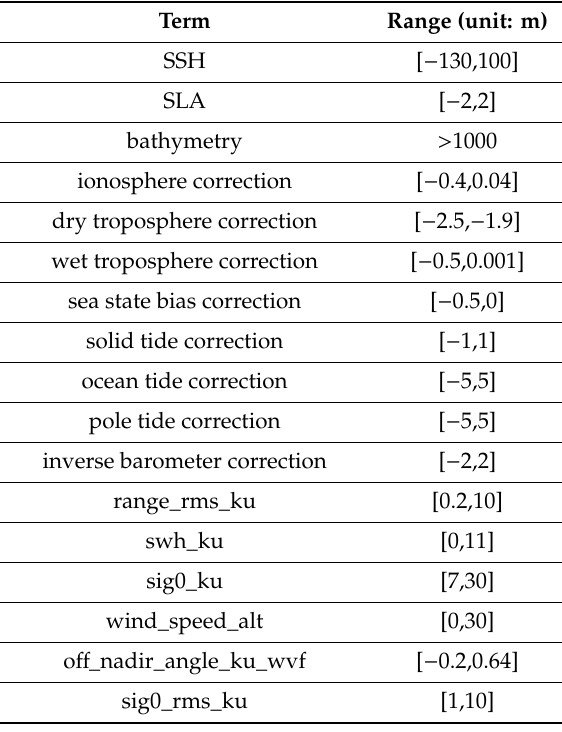
Table 1. Editing criteria of the HY-2A altimeter products.